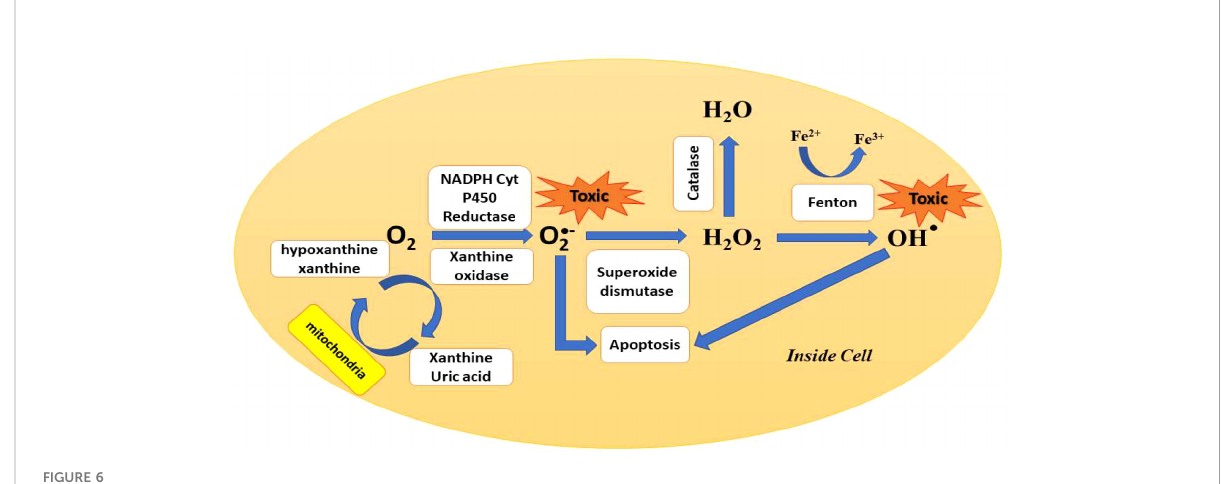
FIGURE 6 Pathways of ROS production and clearance inside the